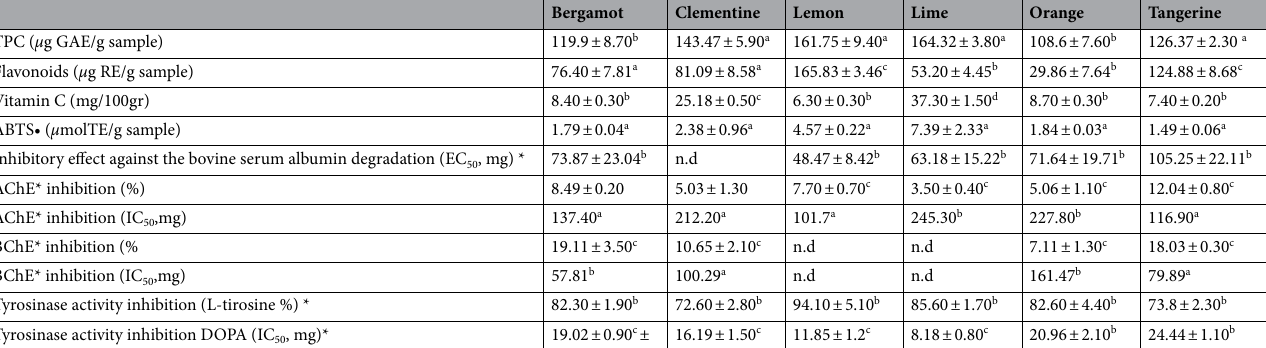
Table 1. Total polyphenol content (TPC), total flavonoids content, vitamin C content, in vitro anti- inflammatory activity, antioxidant activity, cholinesterases and tyrosinase inhibitory activity of the six honeys. Results are expressed as the average of three independent experiments. RE: Rutin equivalent GAE: Gallic acid equivalent. * a: p < 0.5; b: p < 0.01; c: p < 0.001; d: p < 0.0001 compared to the positive control; a: p < 0.5; b: p < 0.01; c: p < 0.001; d: p < 0.0001 compared to the average data (ANOVA followed by Dunnett’s multiple comparison test), n.d. = not